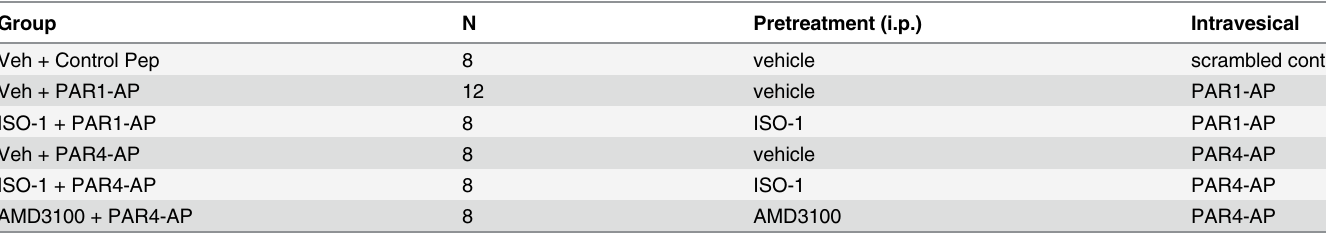
Table 1. Treatment groups for